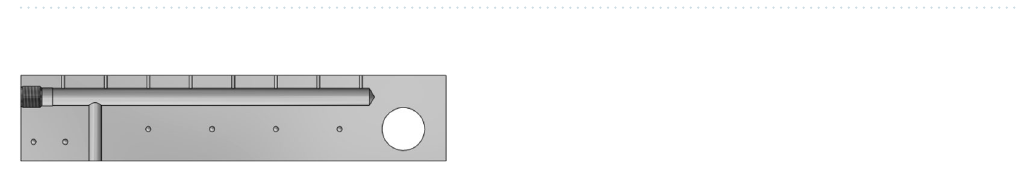
Figure 6. View of the liquid nitrogen distribution